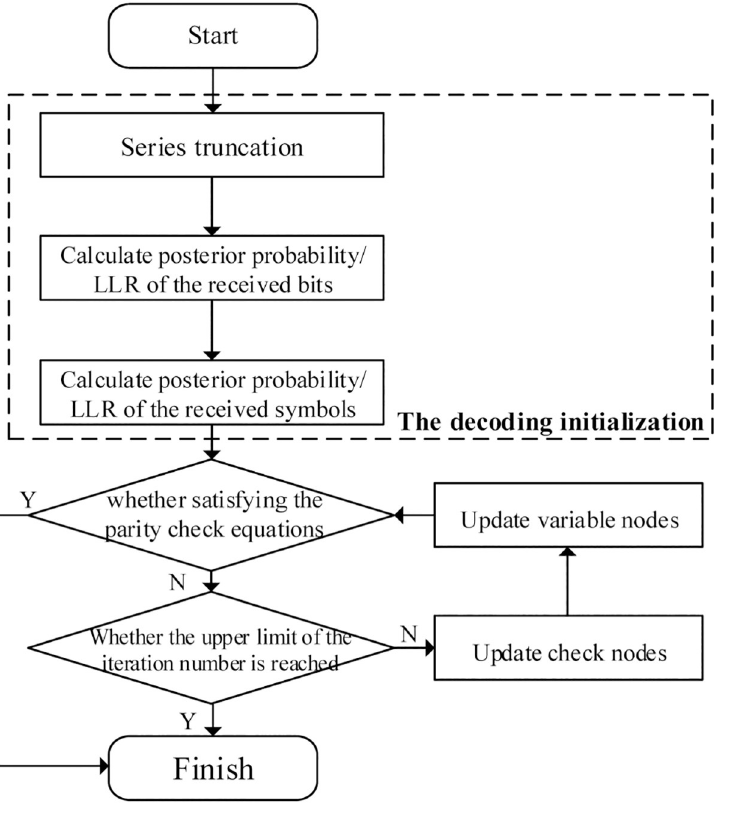
Fig 1. The flow chart of BP decoding for LDPC codes over GF( q ) on AWAN channel.